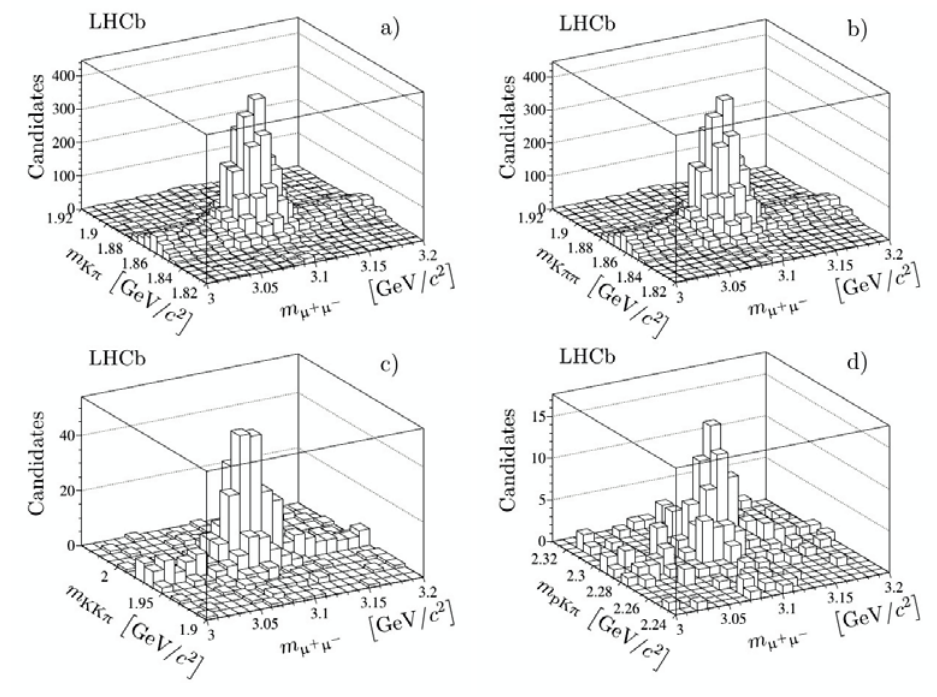
Figure 15. Invariant mass distributions for a) J /ψ D 0 , b) J /ψ D + , c) J /ψ D + s and d) J /ψ Λ + c